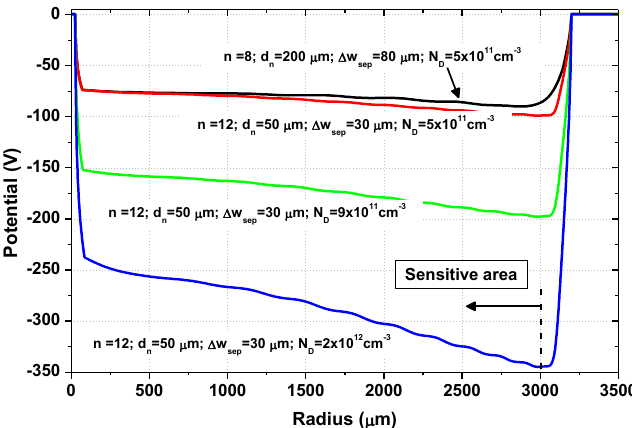
Figure 6. Electric potential along the drift valley of TDDs with various structural parameters and biasing.